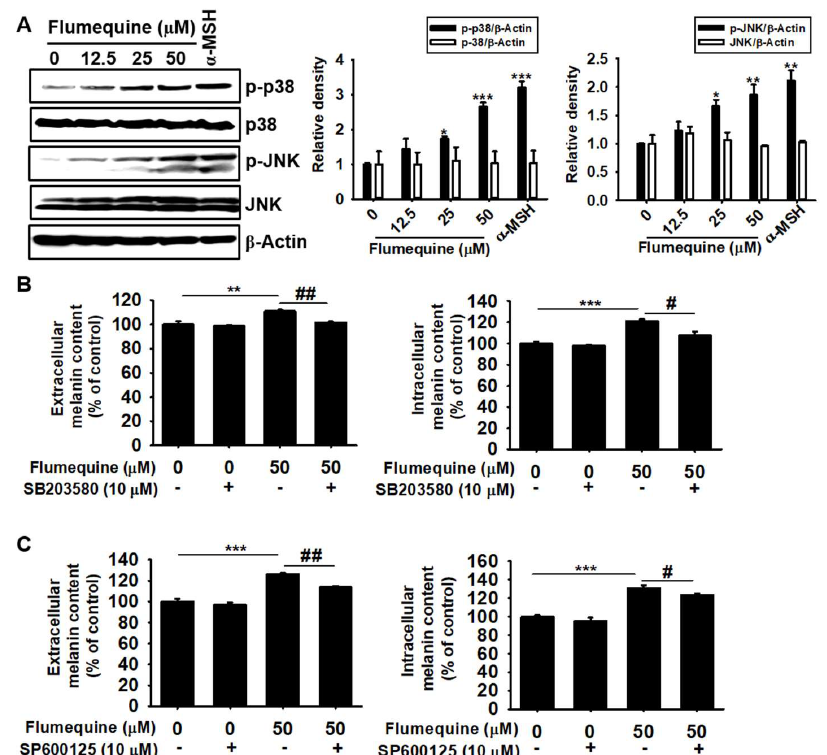
Figure 6. Flumequine induces p38 mitogen-activated protein kinase (MAPK) and c-Jun N-terminal kinase (JNK) phosphorylation, resulting in hypermelanogenesis. ( A ) B16F10 cells were exposed to flumequine (0–50 μM), and phosphorylation of p38 and JNK was measured by western blotting analysis at 72 h. In addition, B16F10 cells were pretreated with 10 μM SB203580 ( B ) or 10 μM SP600125 ( C ) for 1 h and were then treated with 50 μM flumequine for 72 h. Extracellular (left) and intracellular (right) melanin content was measured. The results are the average of three independent experiments and are represented as the mean ± SEM: ***, p < 0.001, **, p < 0.01, and *, p < 0.05 vs. untreated control, and ##